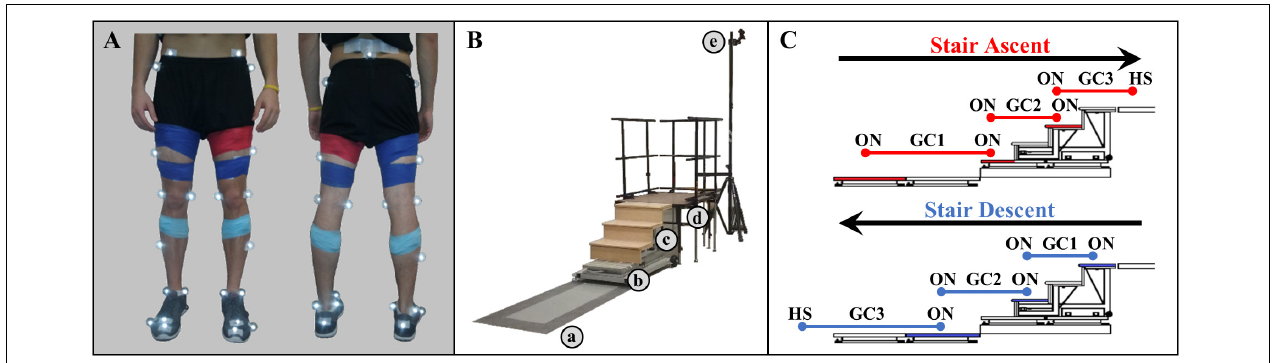
FIGURE 1 | (A) Modified Helen Hayes infrared lower limb marker set and EMG sensor placement. (B) Experimental walkway setup including (a) force plates embedded in the floor, (b) stair force plates, (c) staircase, (d) landing platform, and (e) infrared motion cameras. (C) Schematic of step-over-step stair ambulation gait cycles (GC). Foot contact occurred on the shaded force plates (red, stair ascent; blue, stair